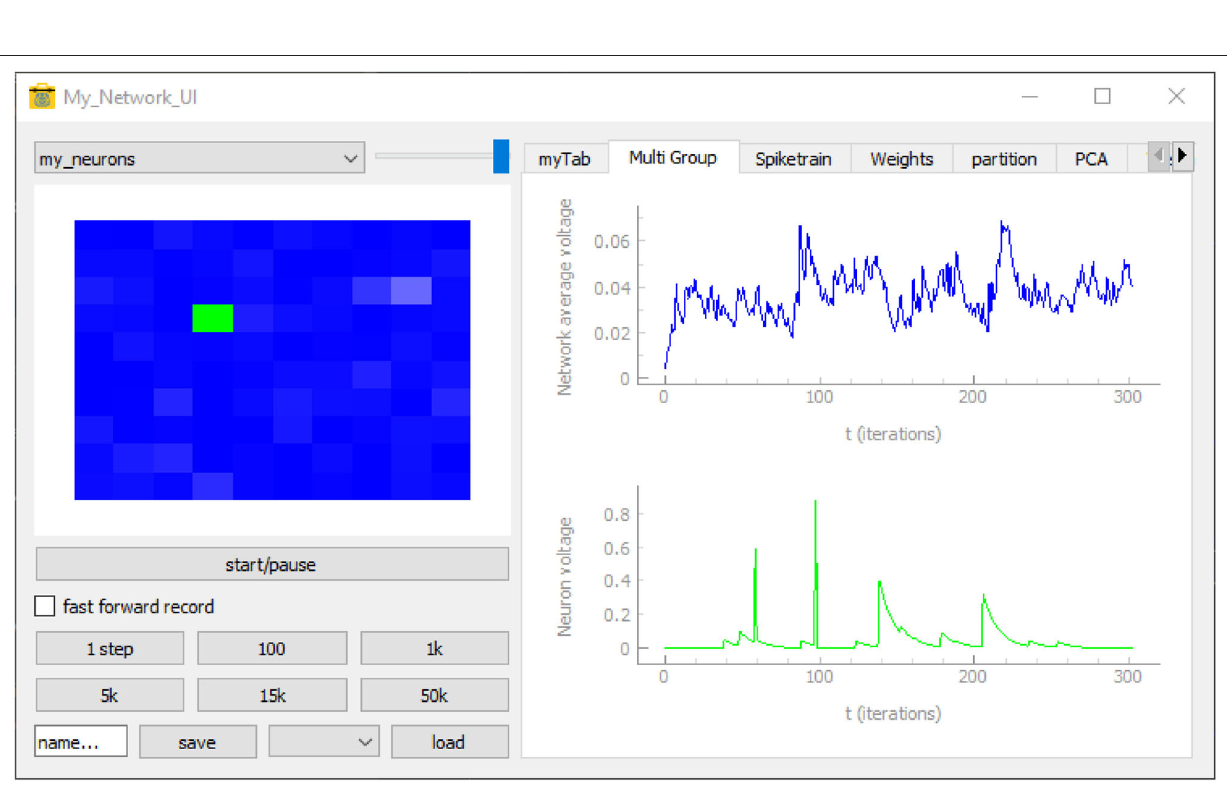
consists of multiple UI_modules , which can be freely